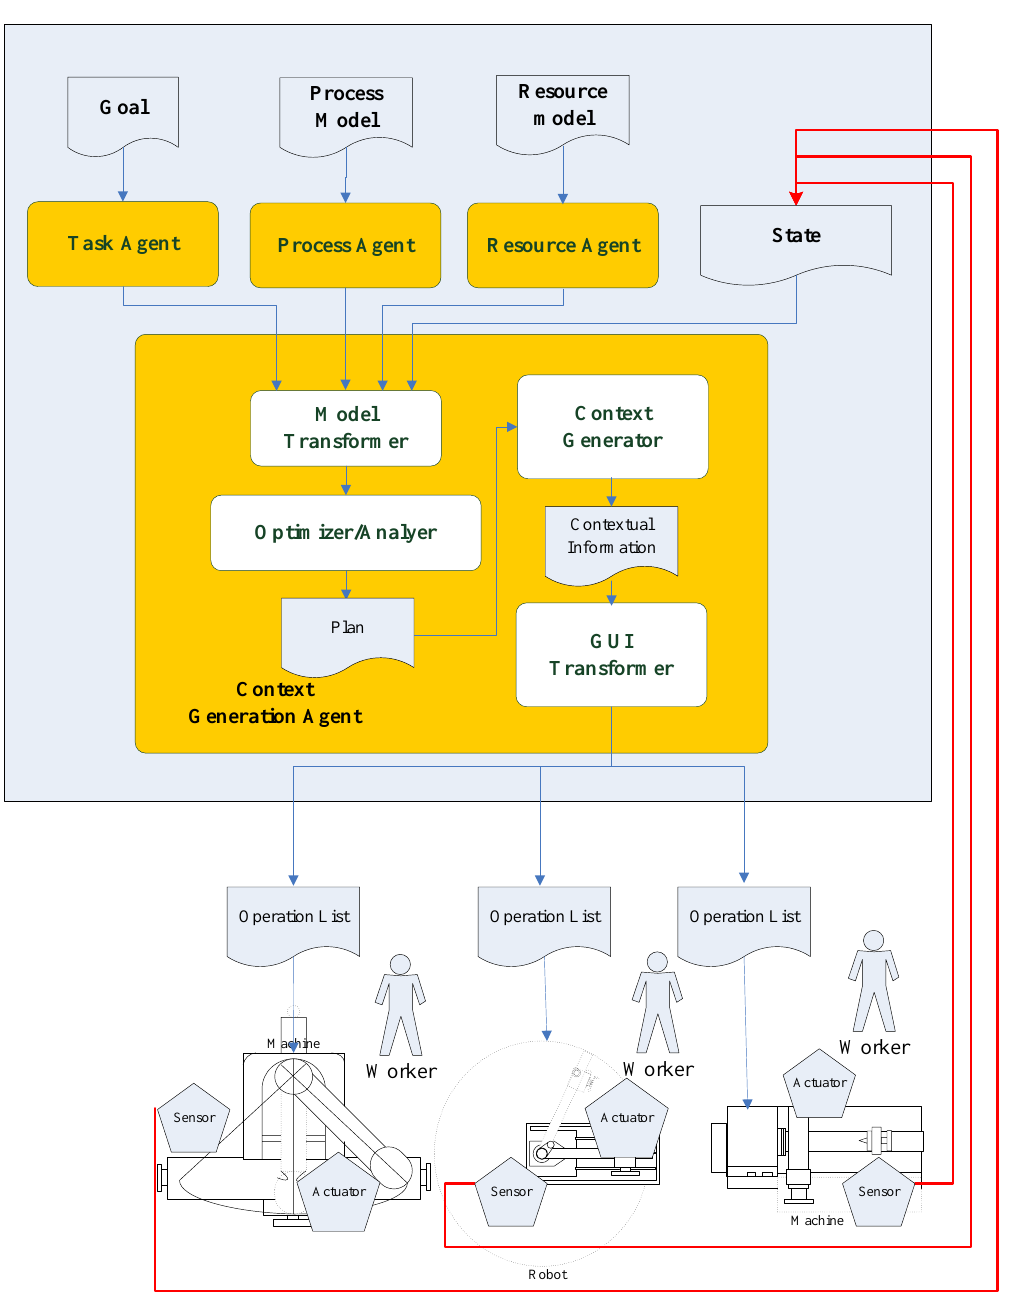
Figure 2. Providing Context-aware Information to Guide Resources/Workers. To generate context-aware information for resources/workers in RMS, a context generation agent must interact with relevant task agent, process agents, and resource agents. The internal architecture of a context generation agent include a model transformer module, an optimizer/analyzer module and a context generator. A context